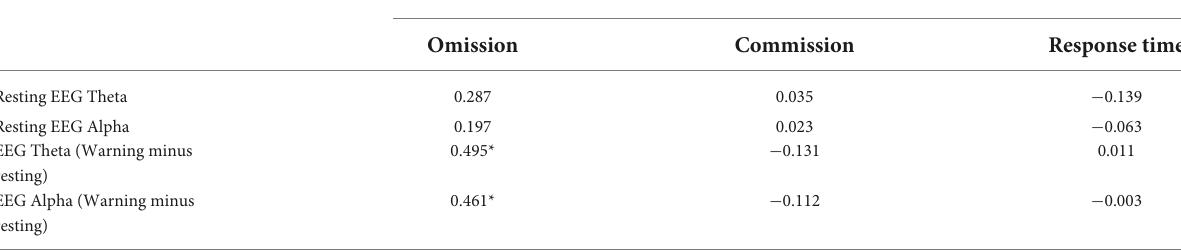
TABLE 2 Correlation coefficients of the CCPT measures with the EEG measures in the SCT group.